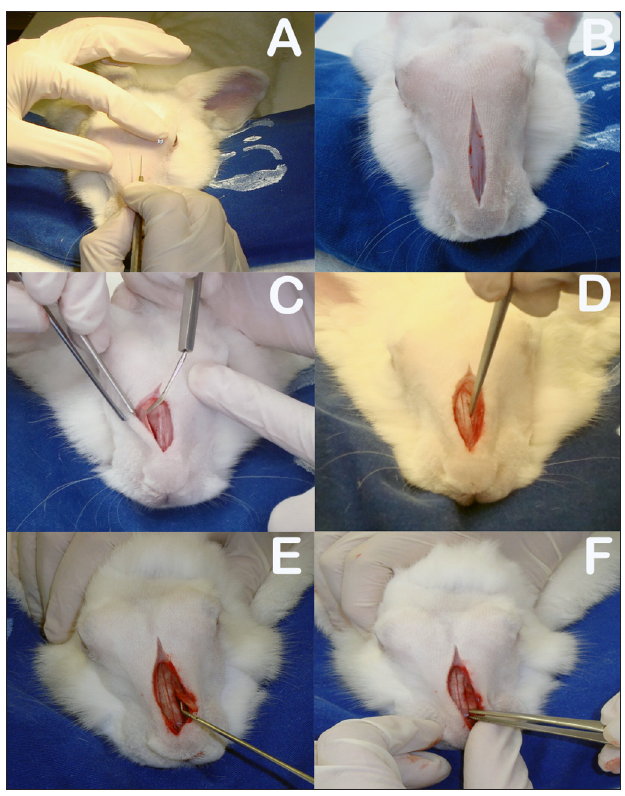
Figura 3. A: Incisão sagital no dorso do coelho; B: Incisão sagital de 5 cm até o periósteo; C: Descolamento do periósteo expondo-se a sutura óssea na linha média e as paredes anteriores de ambos os seios maxilares; D: Confecção com escopro e martelo de um retalho ósseo-mucoso retangular; E: Inserção do implante biodegradável contendo prednisolona no seio maxilar esquerdo; F: Retalho ósseo foi